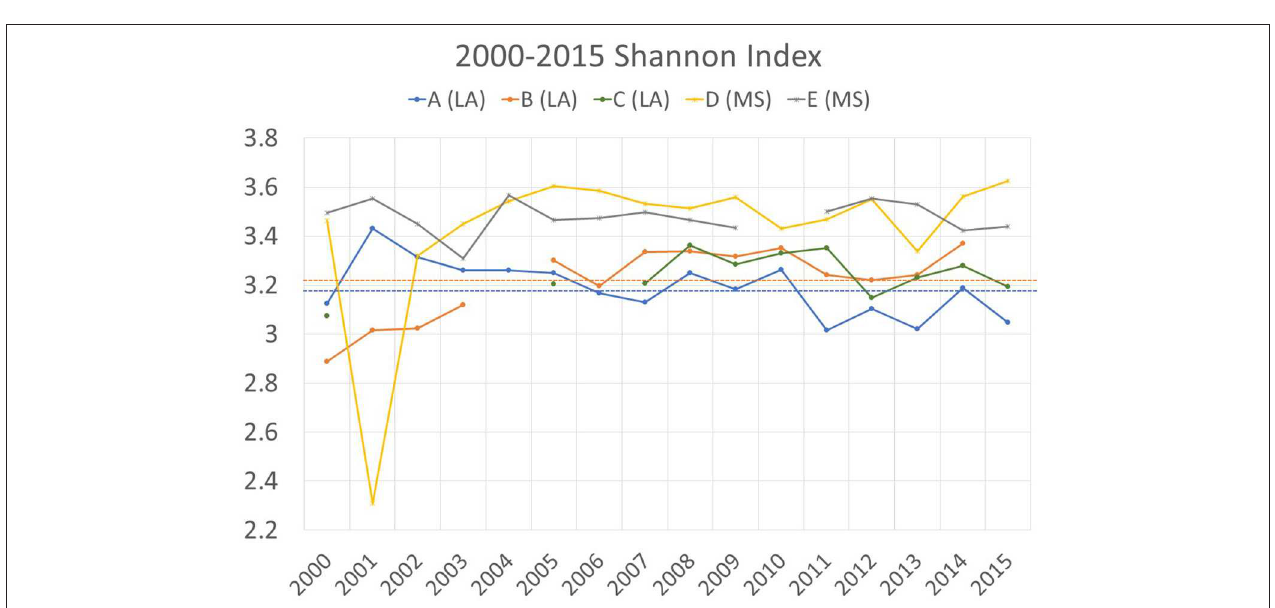
FIGURE 1 | Bird diversity represented by Shannon Index between 2000 and 2015. LA-Louisiana; MS-Mississippi; Dot lines are 15-year average of the two sites in Louisiana.